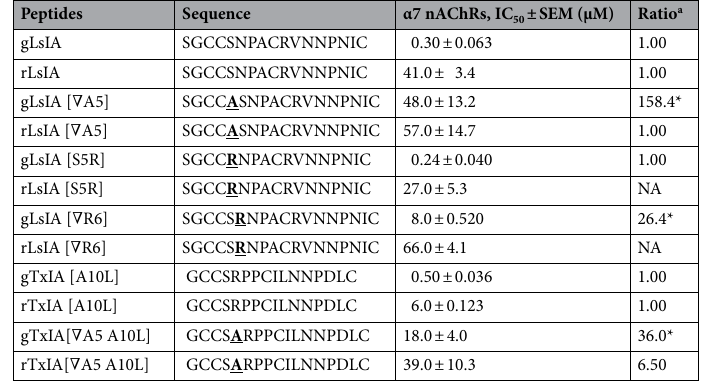
Table 2. IC 50 for the inhibition of choline activation of α7-containing nAChRs in SH-SY5Y cells by LsIA, TxIA [A10L] and analogues. *Denotes significant change in IC 50 compared to wildtype. a IC 50 ratio was calculated between by LsIA, TxIA [A10L] and its corresponding